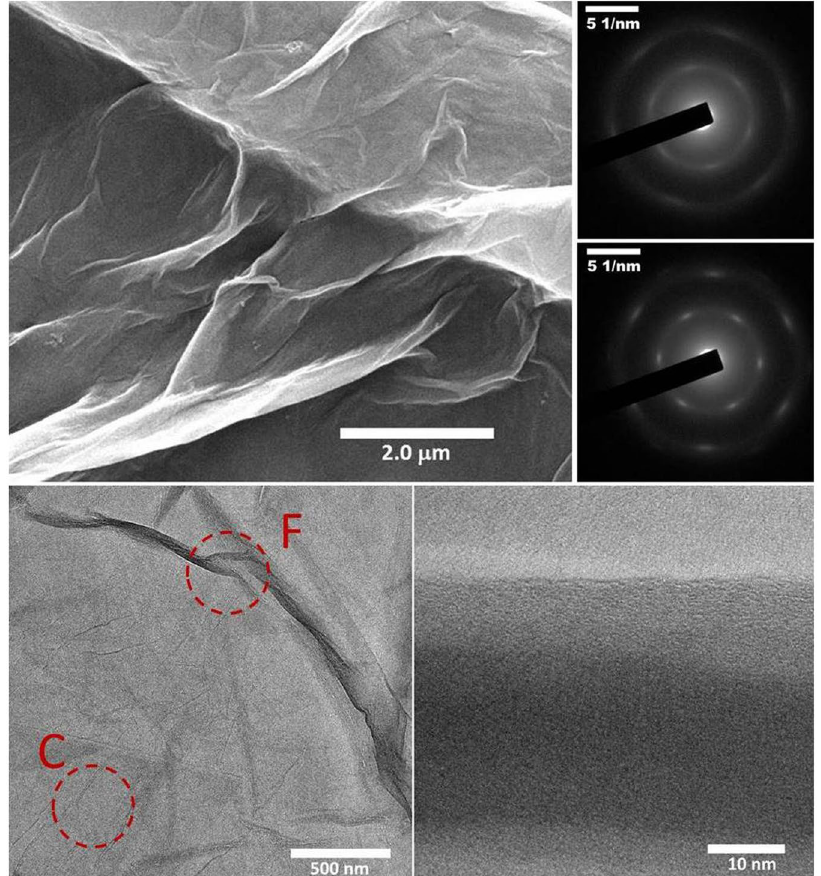
Figure 3. ( a ) SEM image of a spin coated GO film. ( b ) TEM image of a drop casted GO film on the TEM grid. The regions F and C are marked corresponding to the region with and without the wrinkles/folds. ( c ) TEM image of a portion of the drop casted film containing a fold/wrinkle. ( d ) SAED pattern obtained from a region containing wrinkles/folds (similar to F marked in panel (b)). ( e ) SAED pattern obtained from a region which does not contain any wrinkles/folds (similar to C marked in panel